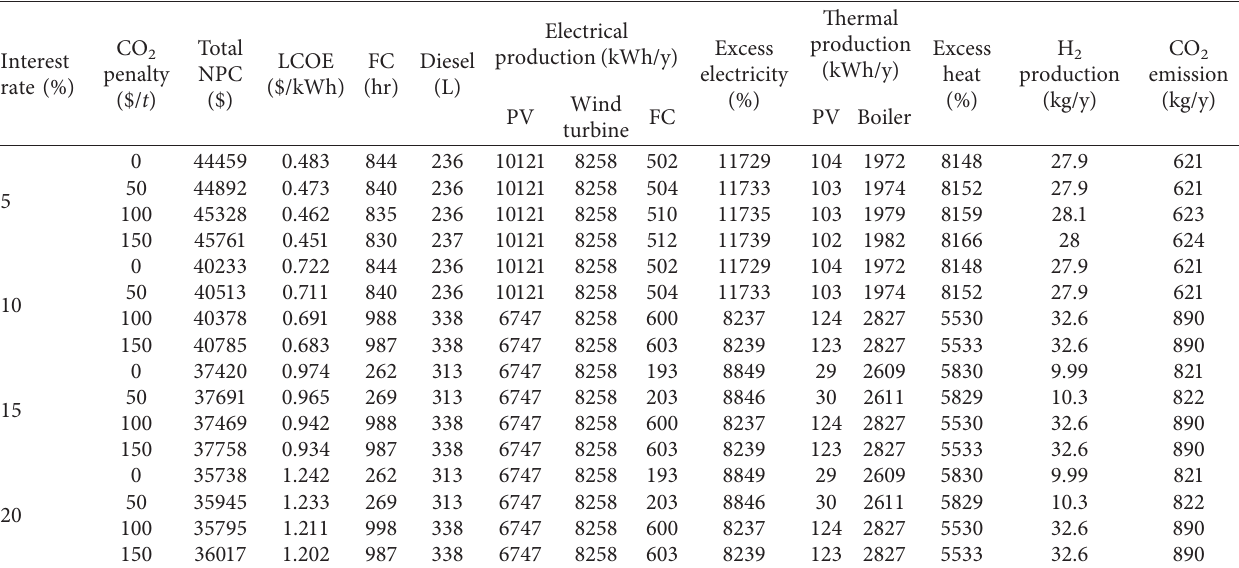
Table 3: Technological-economic-enviromental results of sensitivity